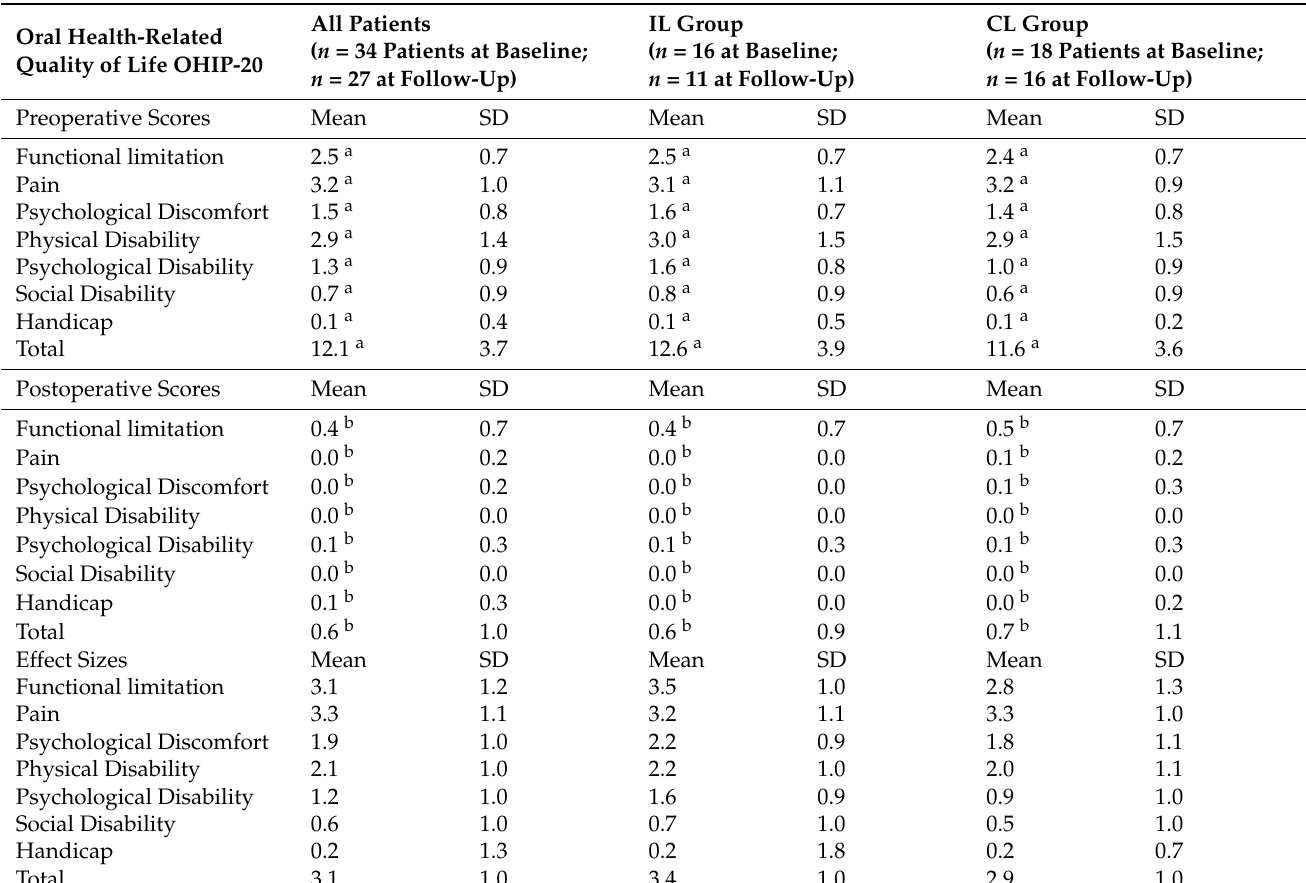
Table 8. Changes in oral health-related quality of life (OHIP-20), by simple count-method ϕ after prosthetic treatments ( n = 34 at baseline; n = 27 at